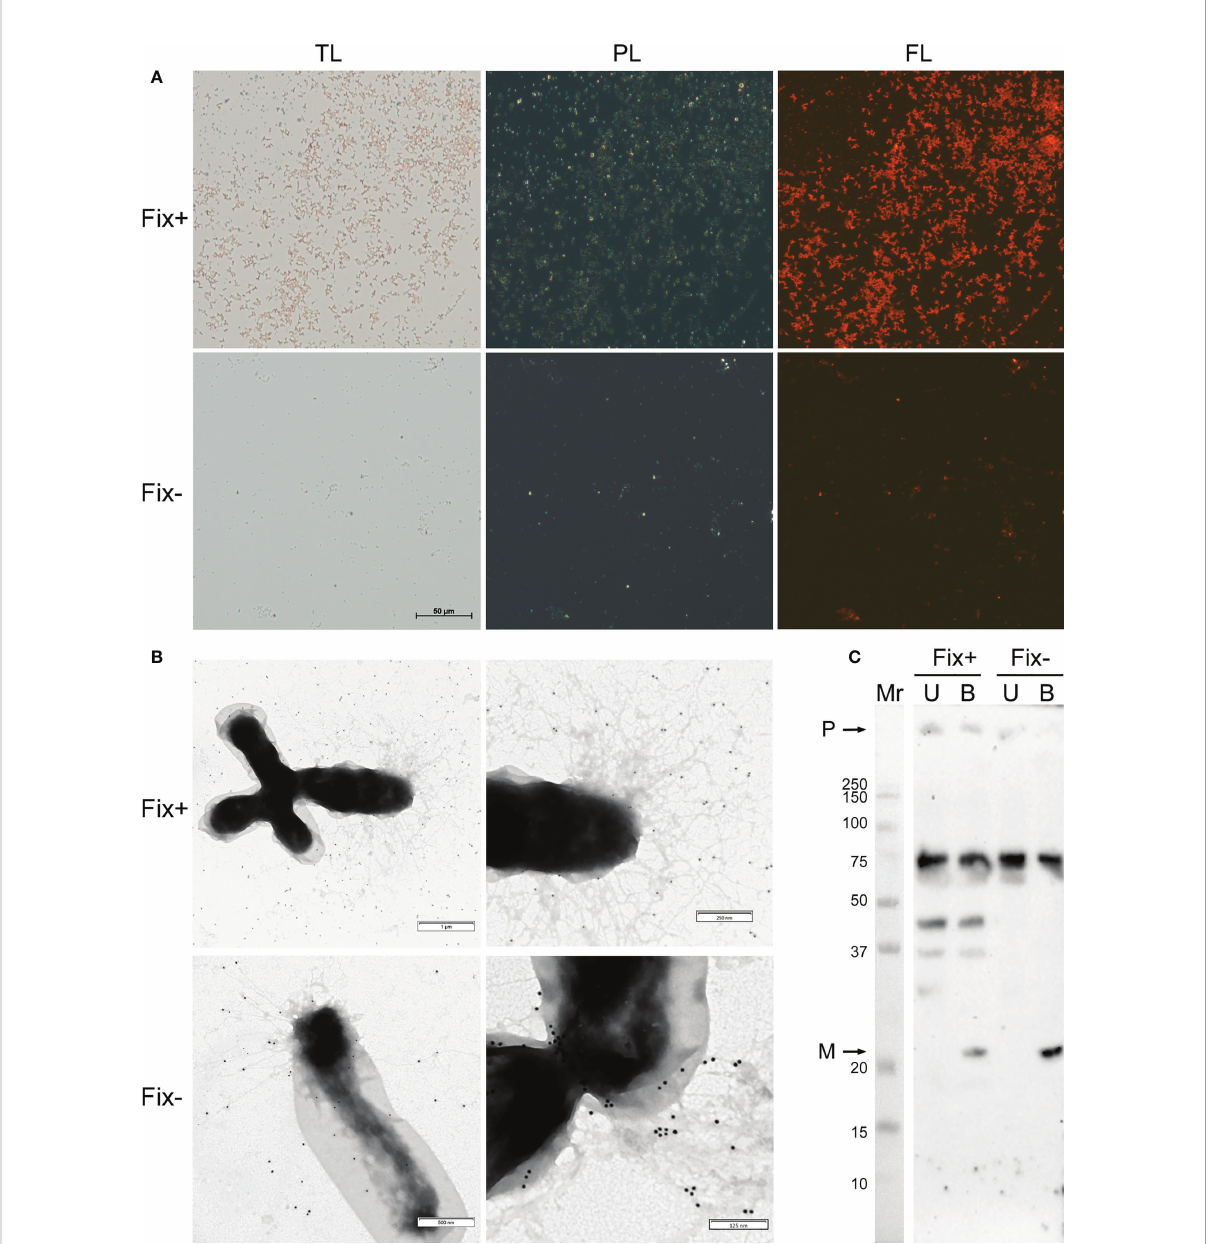
FIGURE 2 Amyloid properties of RopB protein in R. leguminosarum bacteroids extracted from nodules of P. sativum L. formed by wild-type Sprint-2 (Fix + phenotype) and mutant Sprint-2Fix - ( sym31 ) pea lines. (A) Transmitted light (TL), polarization (PL) and fl uorescent (FL) microscopy of Congo red stained bacteroids. All images have the same magni fi cations; scale bar is shown in µm. (B) Immunoelectron images of the bacteroids labelled with anti-RopB antibody visualized by gold-conjugated secondary antibody. Scale bars are indicated. For negative control see Supplementary Figure 4. (C) Detection of the RopB aggregate formation by sodium dodecyl sulfate-polyacrylamide gel electrophoresis (SDS – PAGE) followed by western blot hybridization. Samples treated with cold (U, unboiled) and hot (B, boiled) 2% SDS are shown. “ M ” – monomers, “ P ” – polymers, “ Mr ” – molecular weight marker. Molecular weights (kDa) are